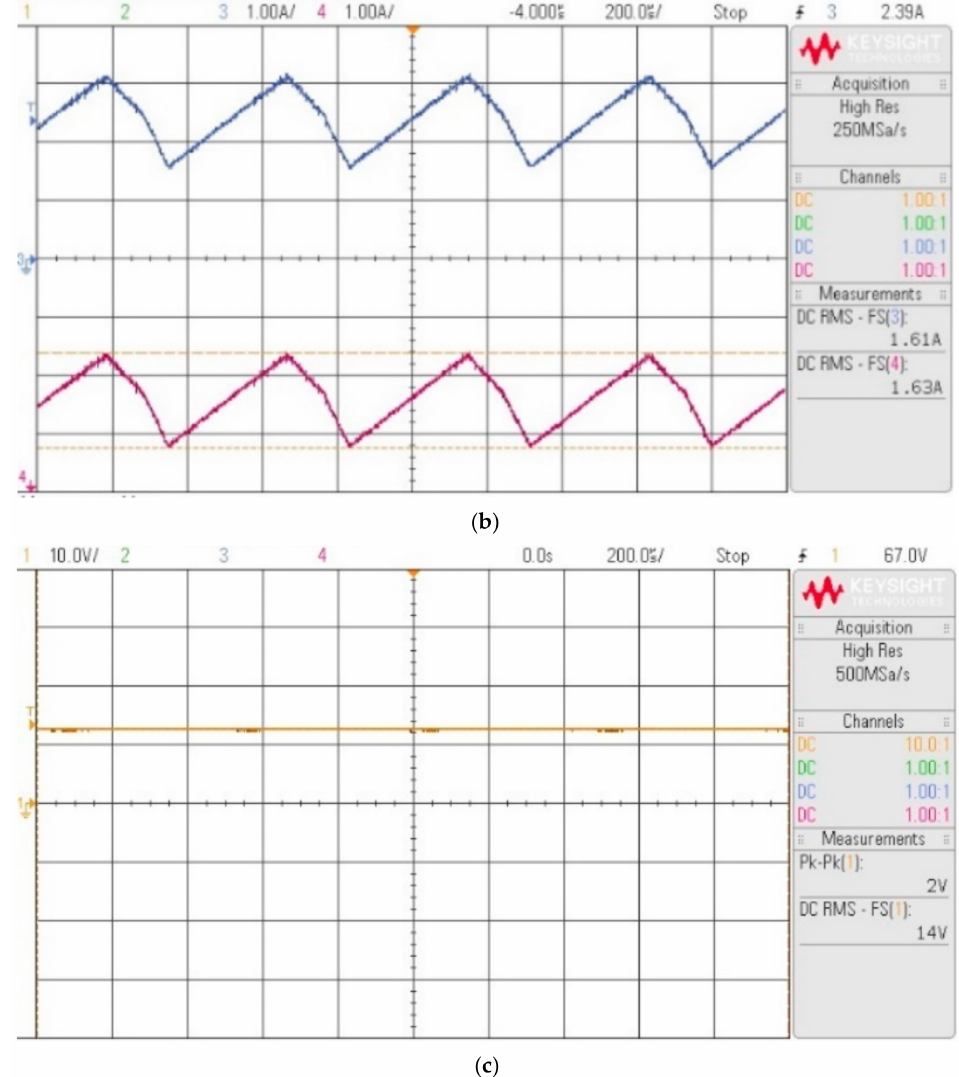
Figure 10. Output waveforms of step-down mode. ( a ) Output voltage and output current, ( b ) inductor voltage (I L1 and I L2 ), and ( c ) capacitor voltage (V C1 ).